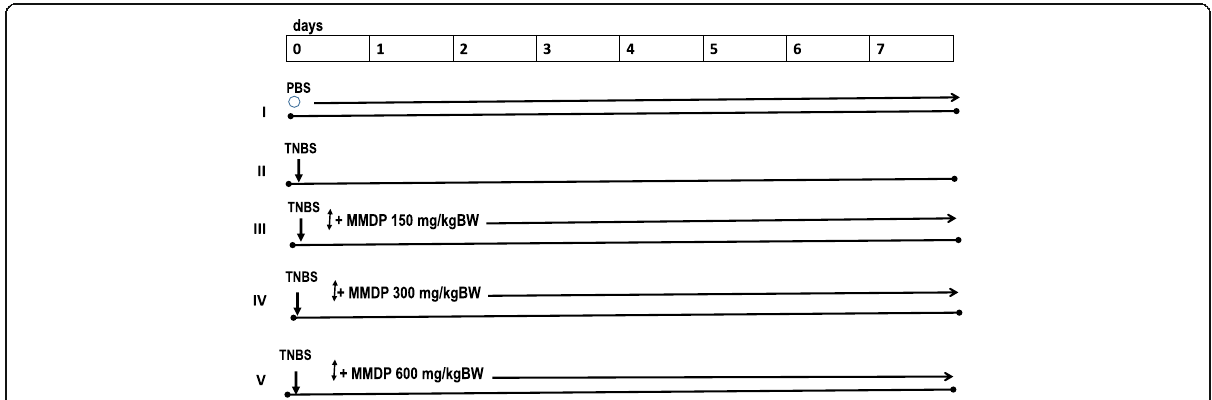
Fig. 1 The experiment design of mice was induced Colitis and MMDP administration. The mice were randomly divided into five groups, each containing 6 mice: I group received 100 μ L of 50% ethanol-phosphate buffered solution (PBS) by rectal needle; II group was given a single rectum injection of 0.5 mg of TNBS only; III-V groups were treated MMDP (150 mg/kg BW, 300 mg/kg BW and 600 mg/kg BW), respectively. The administrated of MMDP were started from the 1st until 7th days. At the end of 7 days, mice in all groups were sacrificed. ○ = PBS, ↓ = TNBS, ↕ =